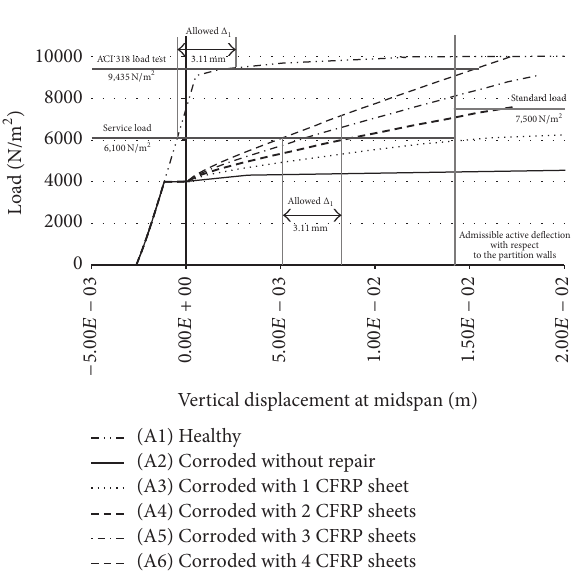
Figure 7: Load-vertical displacement at midspan curves for simply supported T-joist